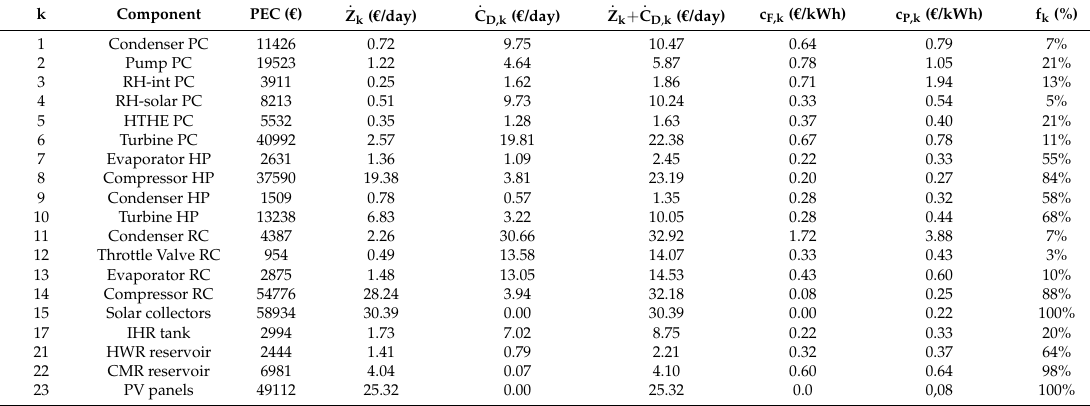
Table 8. Values of selected exergo-economic variables for system operating on reference day of May in Crotone.